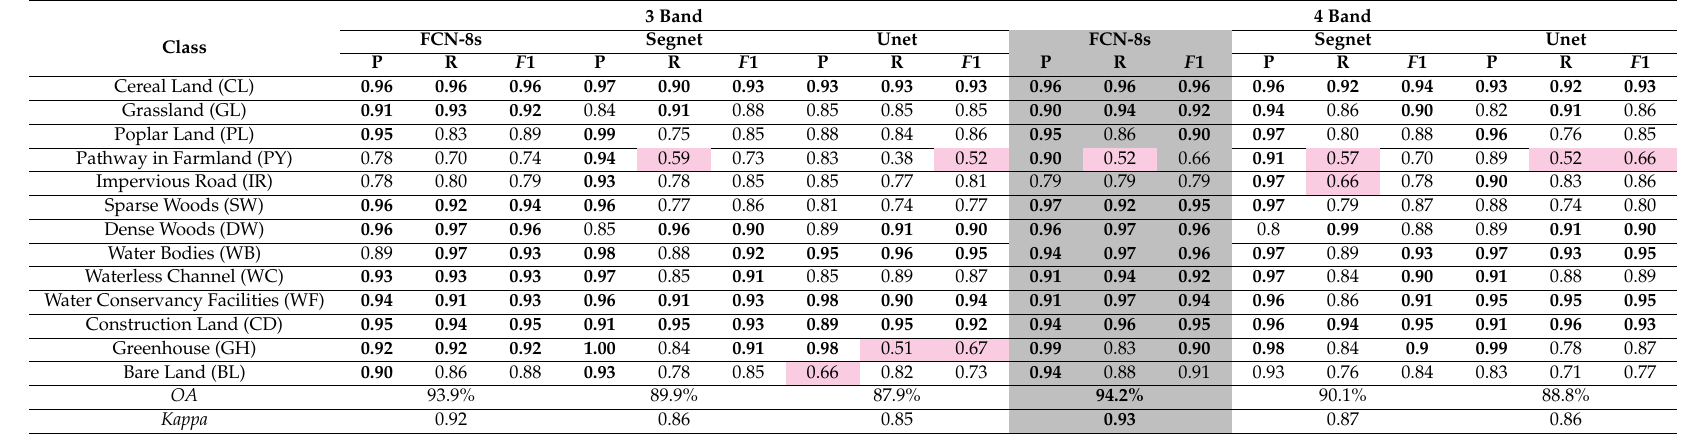
Table 2. The classification accuracy among FCN-8s, Segnet, and Unet with three bands and four bands as input for the study area using the per-class precision (P), recall (R), F 1-score ( F 1), overall accuracy ( OA ) and Kappa coe ffi cient ( Kappa ). Per-class accuracy rates below 0.7 are colored pink-red, while accuracy rates over 0.9 are marked with bold. The overall highest OA and Kappa (last two rows) are marked bold. The method with the highest OA and Kappa is marked with a grey